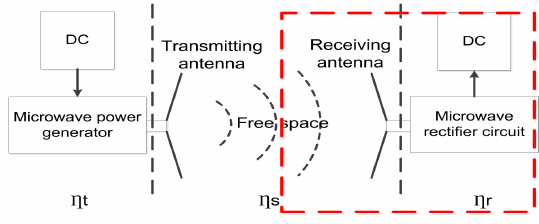
Figure 1. Schematic diagram of an MWPT